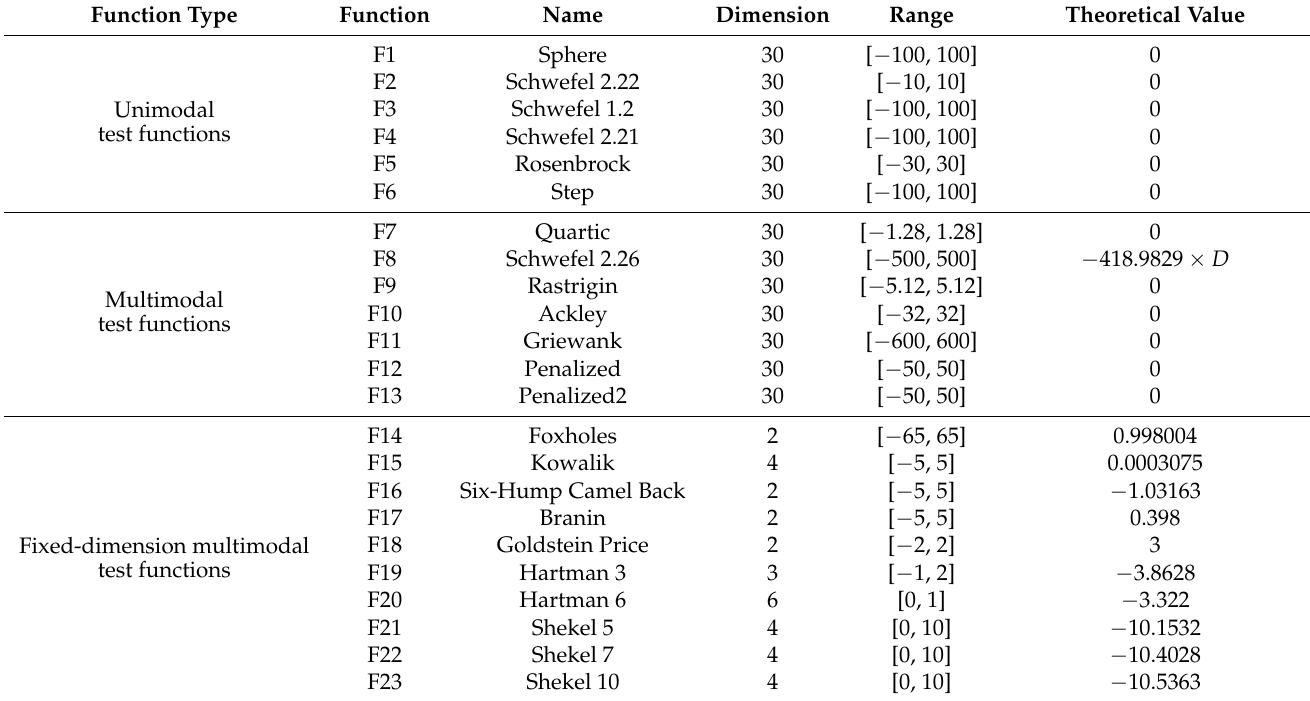
Table 2. The classic benchmark functions.